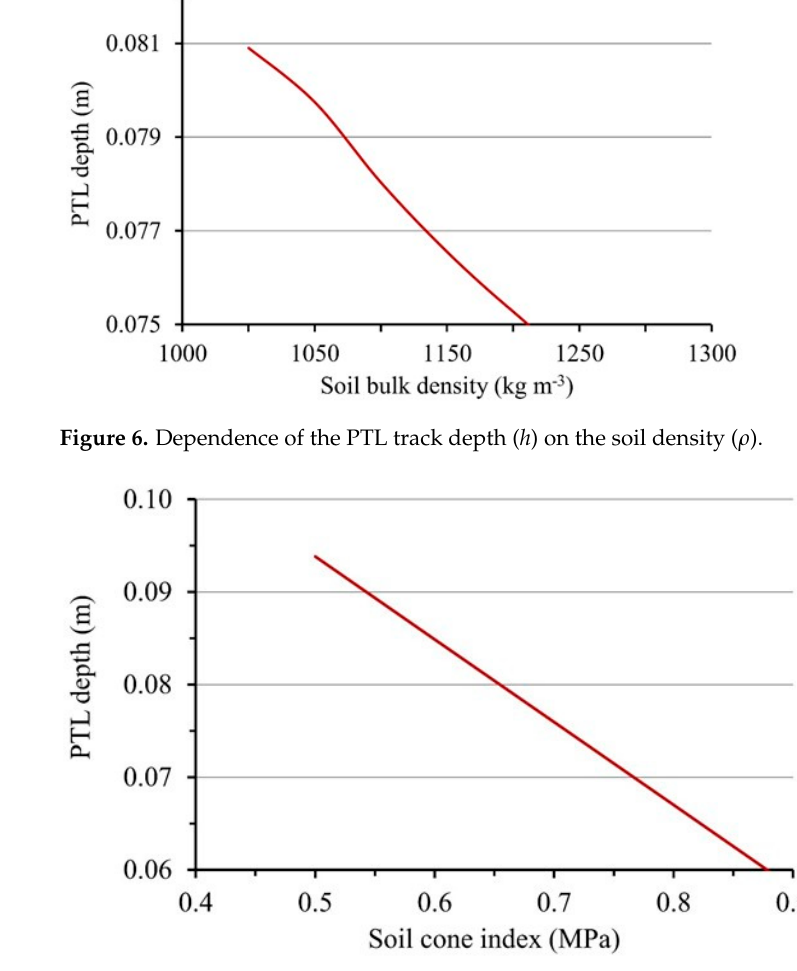
Figure 7. Dependence of the PTL track depth ( h ) on the soil cone index ( H ).